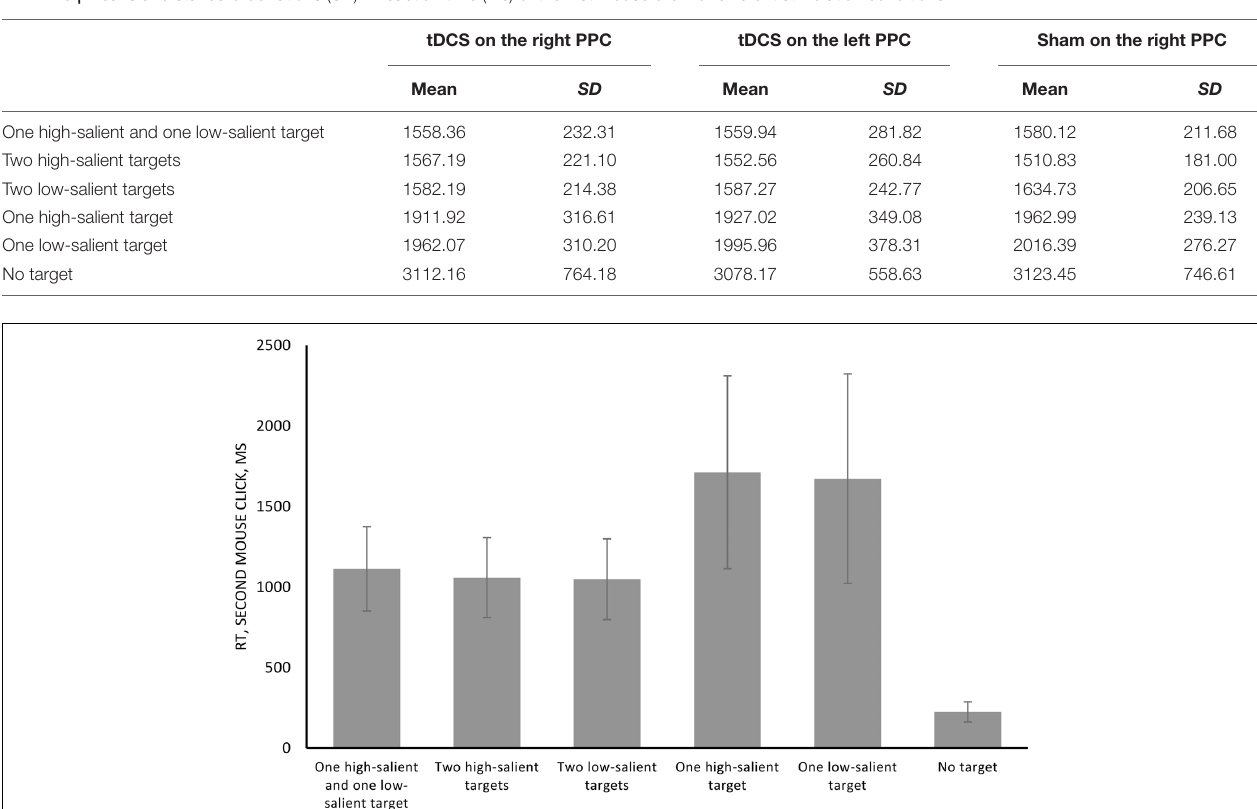
of the first target, thereby consuming the resources of attention and/or working memory. At this end, cathodal stimulation of right PPC was supposed to decrease the amount of available